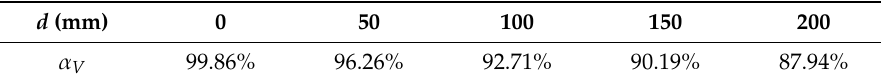
Table 1. Comparison of the vertical stability of the inner receiver coil.